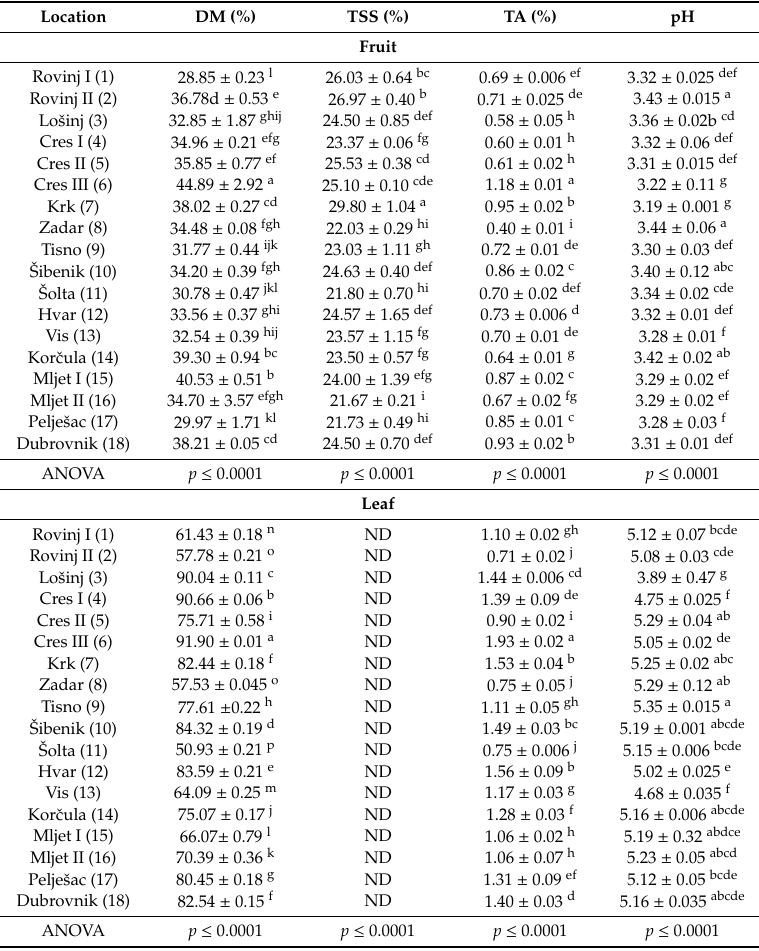
Table 1. Physical-chemical composition parameters of Strawberry tree fruit and